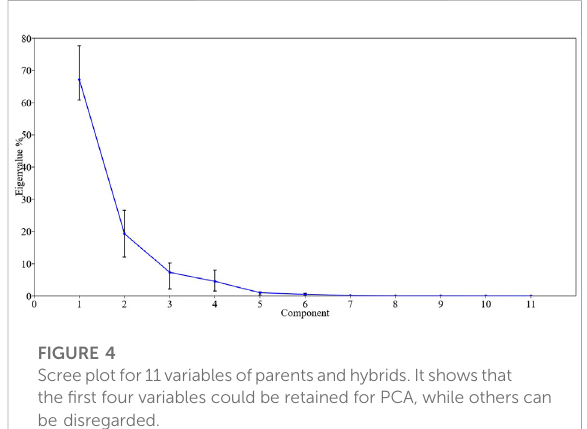
FIGURE 4 Screeplotfor11variablesofparentsandhybrids.Itshowsthat the fi rst four variables could be retained for PCA, while others can be disregarded.